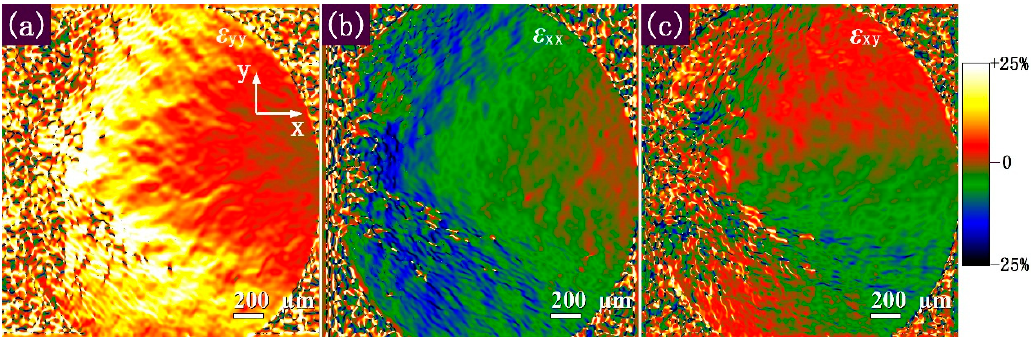
Figure 8. Strain fields at 390 N during the decreasing load corresponding to Figure 3g measured by using the GPA method: ( a ) ε yy strain field; ( b ) ε xx strain field; ( c ) ε xy strain field.